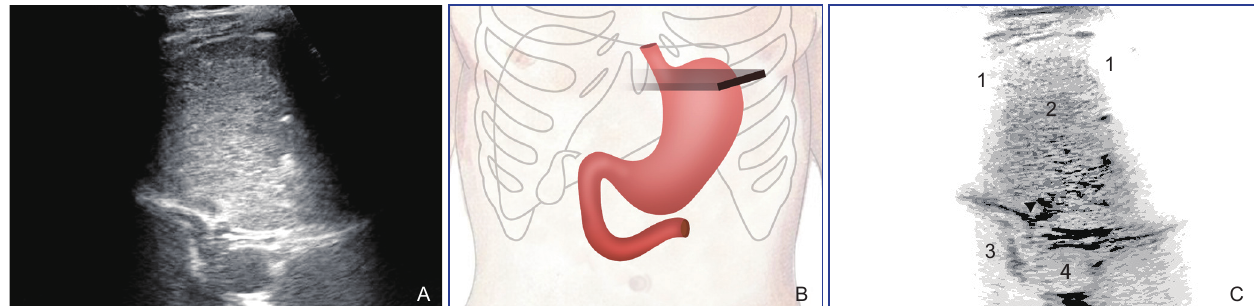
Figure 3 Schematic diagram of ultrasonic image and scanning of short axis section of cardia (scanning through left intercostal section). A, Ultrasound image; B, Scan the schematic diagram; C, Ultrasonic schematic diagram (1, Sound shadow of ribs; 2, Stomach; 3. Left lobe of liver; 4. Aorta. ▼,